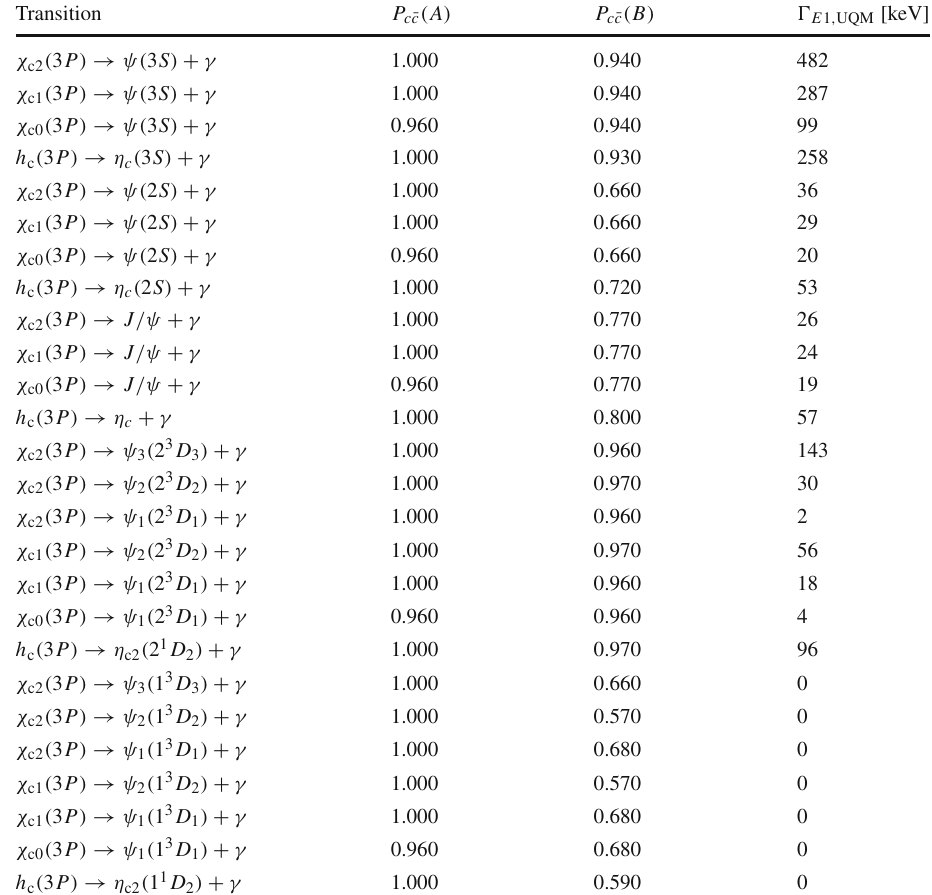
Table 2 E 1 radiative decay widths of χ c ( 3 P ) states in the UQM formalism. The second and third columns report the normalizations of initial ( A ) and final ( B ) charmonium. Our UQM predictions, (cid:6) E 1 , UQM , are computed according to Eq. (10), where the QM results, (cid:6) E 1 , QM , can be extracted from Ref. [69]. The large values of the P c ¯ c probabilities for χ c ( 3 P ) s are due to the conservative renormalization prescription used in our UQM calculation of the radiative decays. See the explanation in the text and also in Ref.